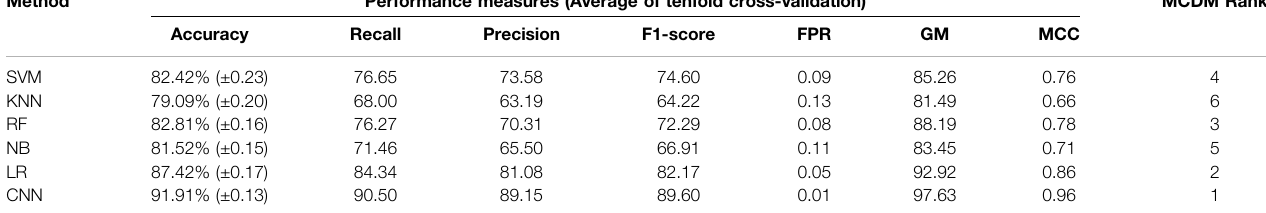
TABLE 4 | Models performance and ranking for external data (methylation).